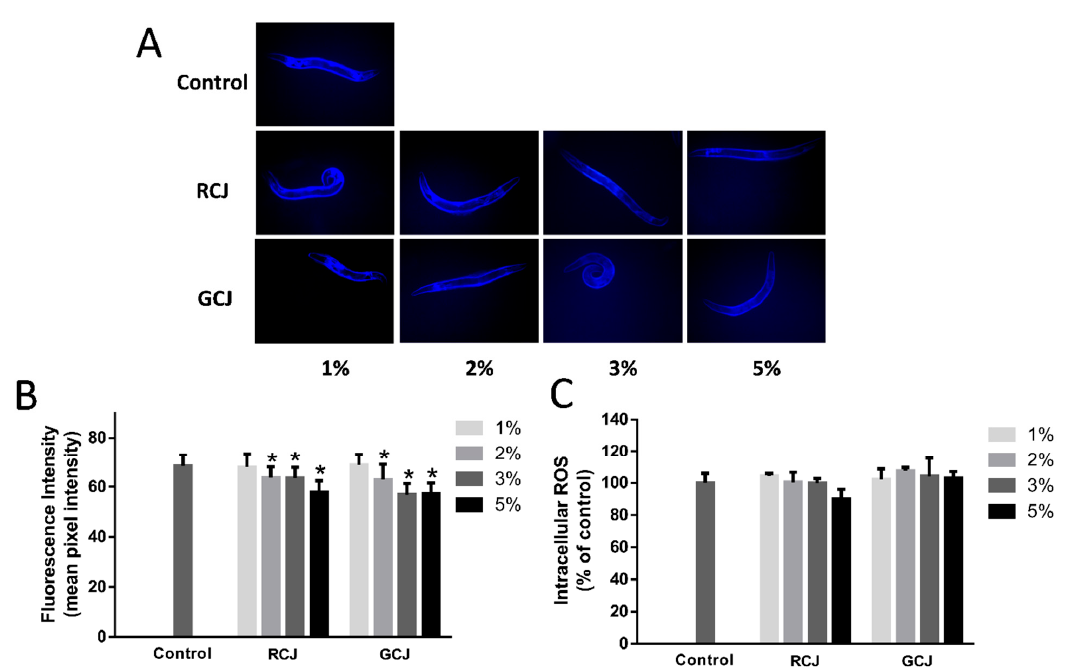
Figure 4. Effect of red cabbage juice (RCJ) and green cabbage juice (GCJ) on autofluorescence ( A , B ) and ROS ( C ) accumu- lation. ( A ) Representative images of autofluorescence from RCJ- and GCJ-treated worms on day 8. The images were taken with a DAPI filter set and at 100× magnification. ( B ) Mean fluorescence intensity from autofluorescence in day 8 worms treated with RCJ and GCJ ( n = 20). (C) Synchronized L1 larvae worms were treated with RCJ and GCJ for 2 days and collected for determination of ROS level using DCF assay ( n = 30). Data are presented as mean ± SD. * p < 0.05 vs. control by one-way ANOVA followed by Bonferroni correction.